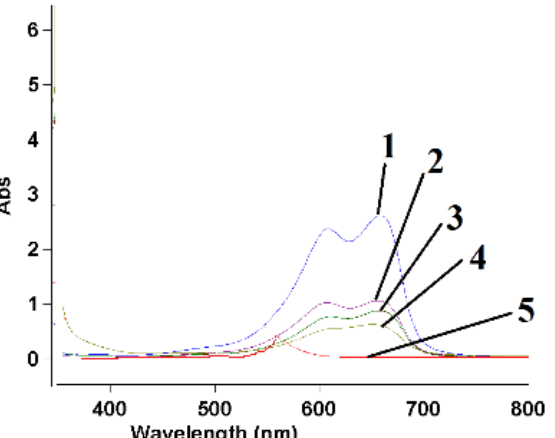
Figure 16. UV–vis absorption spectra of the solution before processing with the sorbent ( 1 ) and 15 ( 2 ), 30 ( 3 ), 45 ( 4 ), and 60 min ( 5 ) after SPE.